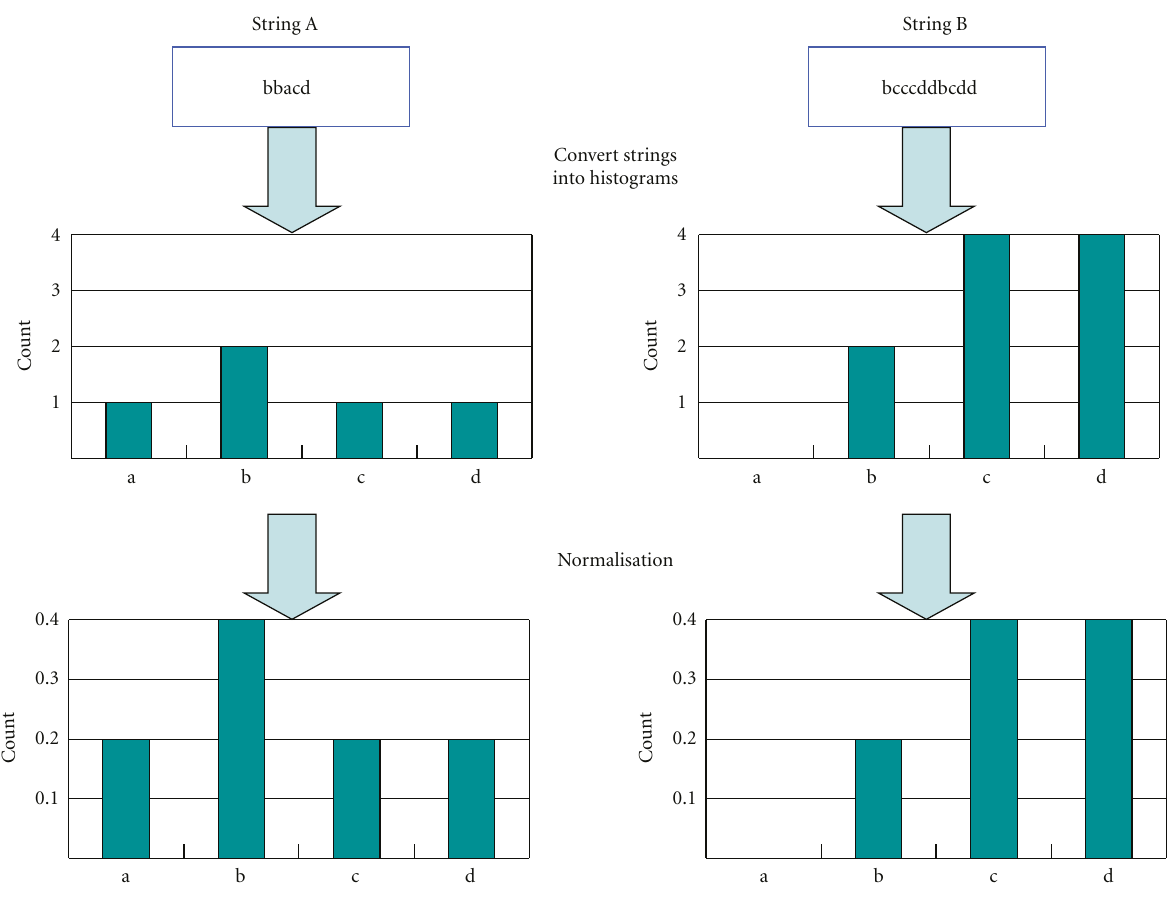
Figure 4: The illustration of converting strings to